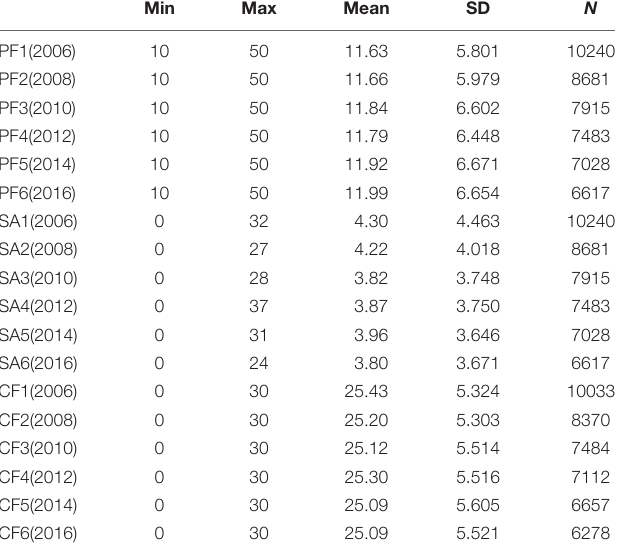
TABLE 1 | Descriptive statistics of the variables.